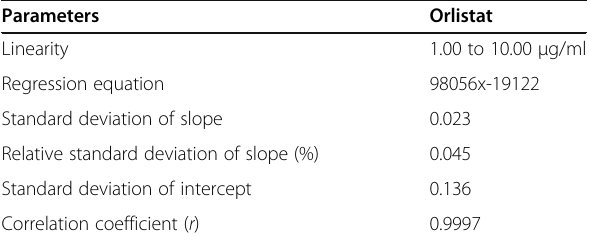
Table 2 Statistical data of calibration curves of Orlistat